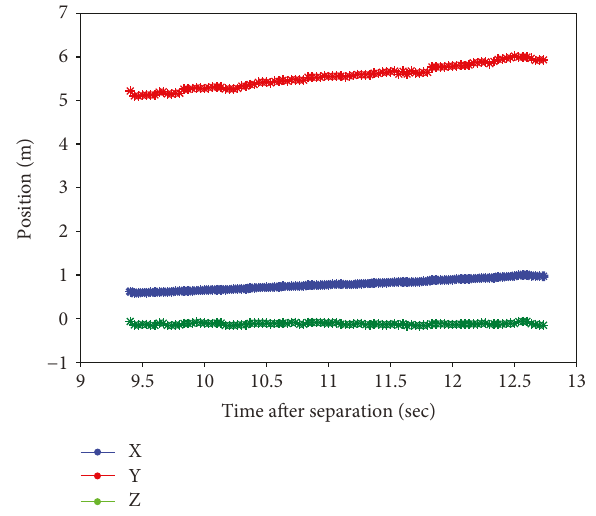
Figure 13: The relative position of the “ Chibis-M ” center of mass.